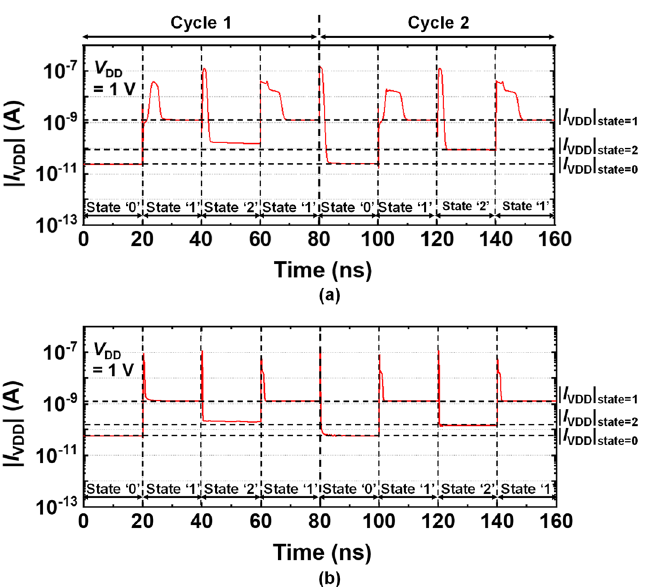
Figure 6. Transient response of I VDD versus time for (a) L G = 500 nm and (b) L G = 14